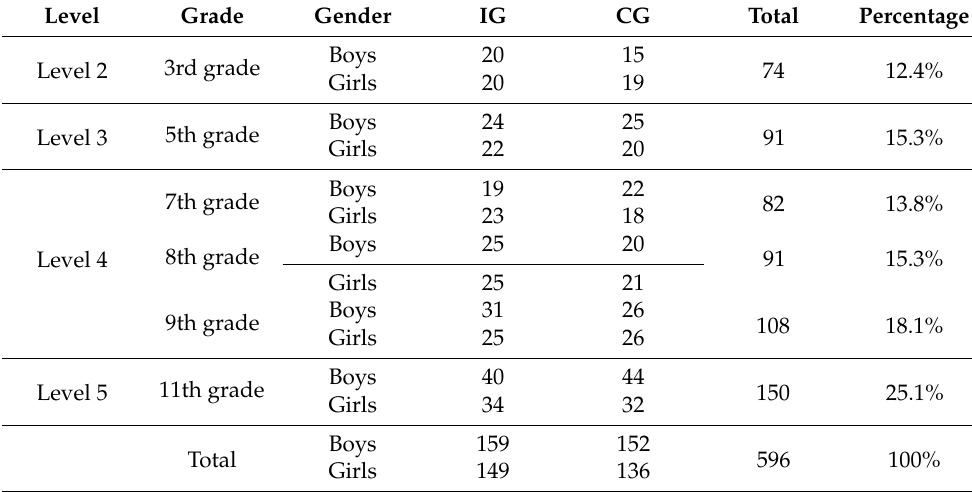
Table 1. List of gender distribution of research subjects.